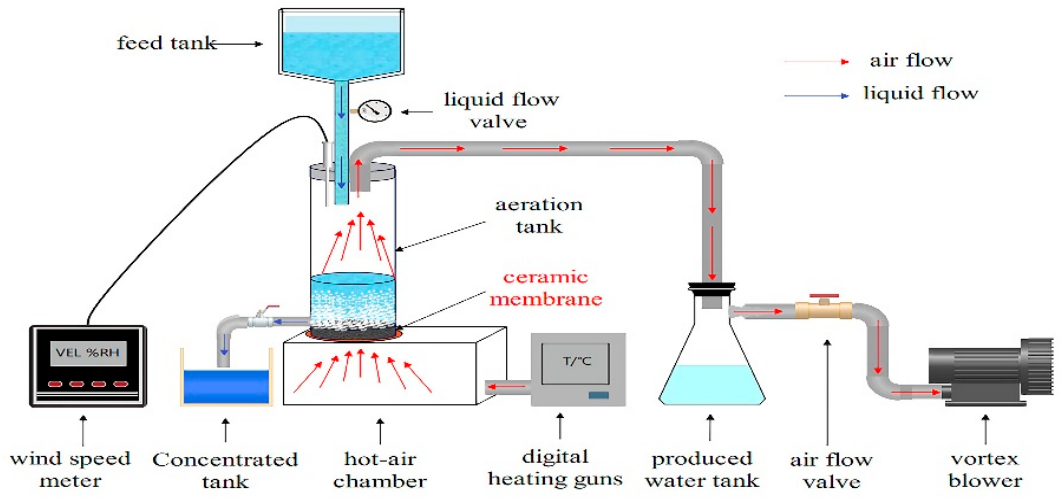
Figure 1. Schematic diagram of evaporation using a ceramic aeration membrane.